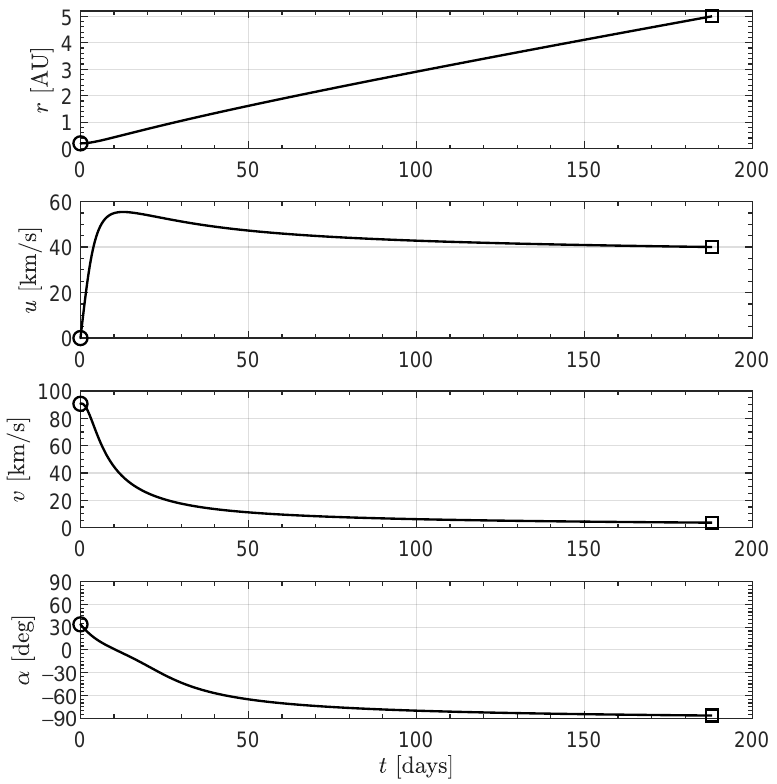
Figure 12. Osculating parameters of the transfer orbit, spacecraft velocity components and optimal steering law to reach a distance of 5au with V ∞ =